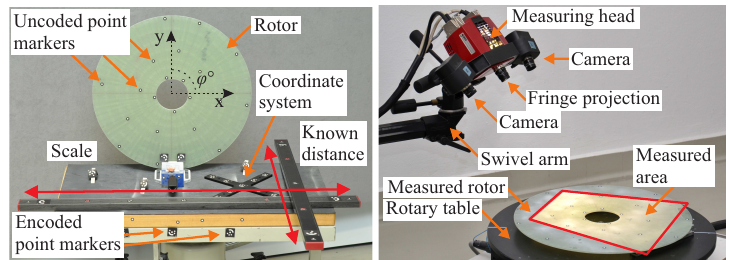
Figure 5. Arrangement of the rotors for the creation of reference point clouds using the T RITOP system ( left ), and for the measurement of the manufacturing variations on a rotating table using the A TOS system ( right